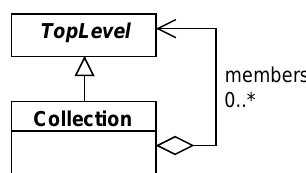
Figure 19: Diagram of the Collection class and its associated